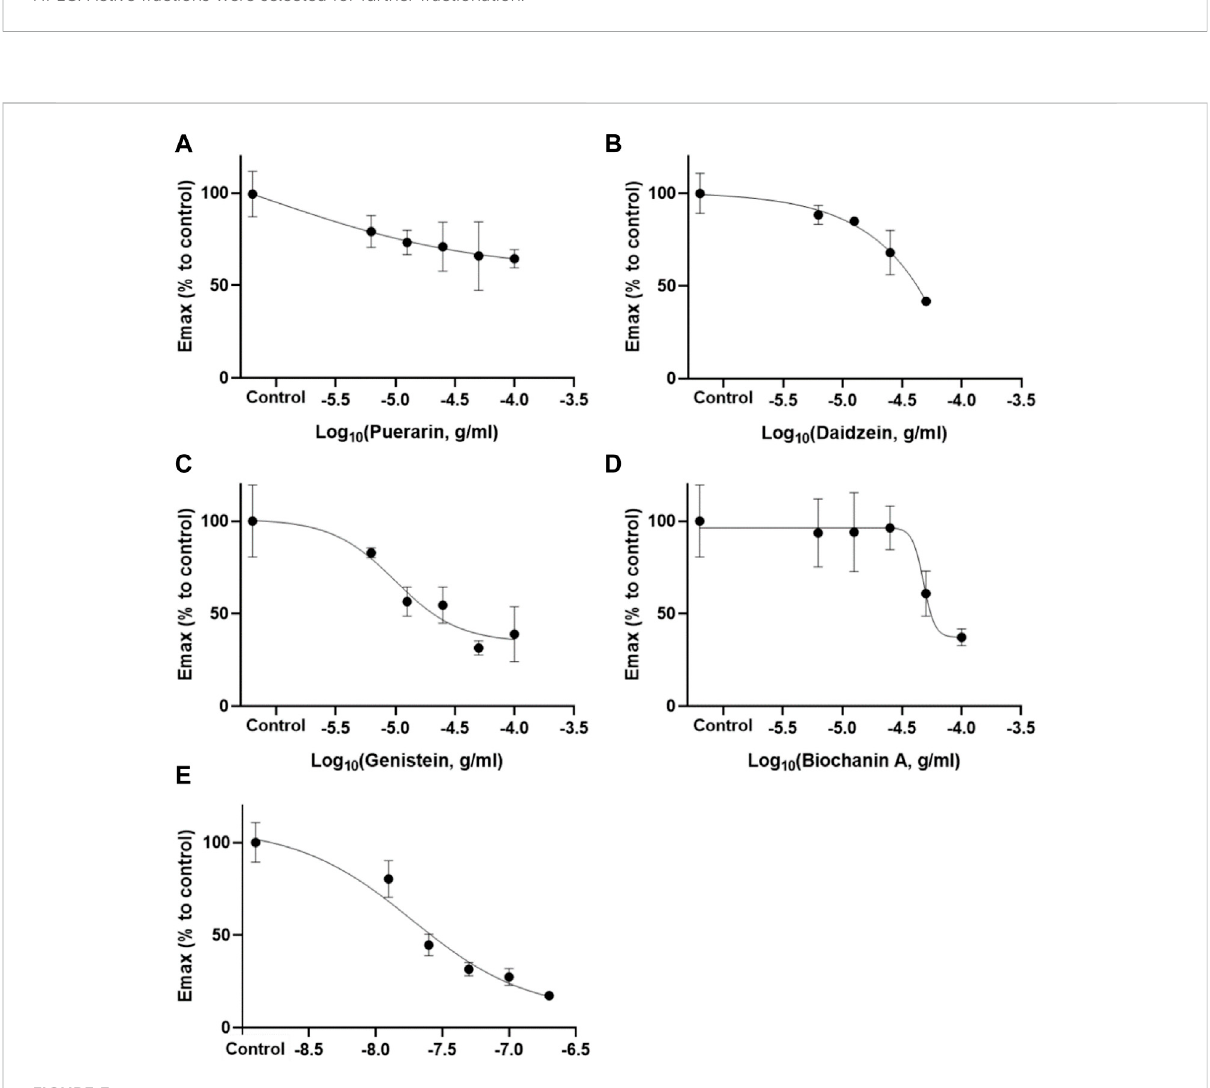
FIGURE 3 Inhibitory effects of puerarin (A) , daidzein (B) , genistein (C) , and biochanin A (D) at different concentrations (6.25 – 50 or 100 μ g/ml) against carbachol (10 μ M)-induced detrusor contraction (Mean ± SEM; n = 3). Darifenacin (D) (12.5 – 200 ng/ml) served as the positive